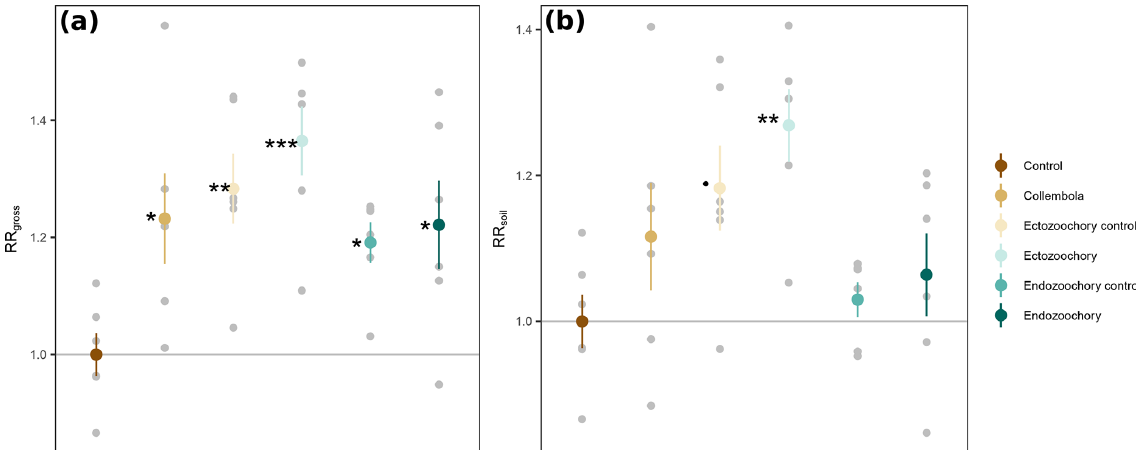
Figure A1. Response ratios of permafrost cumulative CO 2 production rates to addition of Collembola. (a) RR gross : measured CO 2 production rates. (b) RR soil : measured CO 2 production rates with estimated Collembola basal respiration subtracted. All values are divided by the mean of the no-Collembola control; small grey circles are individual jar values; large symbols are means; error bars are standard errors of the mean ( n = 6). Black symbols denote significant difference from the control; different symbols denote different statistical significance (estimated marginal means treatment contrasts with Holm adjustment for multiple comparisons, Appendix Table A2; dot ( · ) denotes 0.05 <P < 0.1; ∗ 0.01 <P < 0.05; ∗∗ 0.001 <P < 0.01; ∗∗∗ P < 0.001).